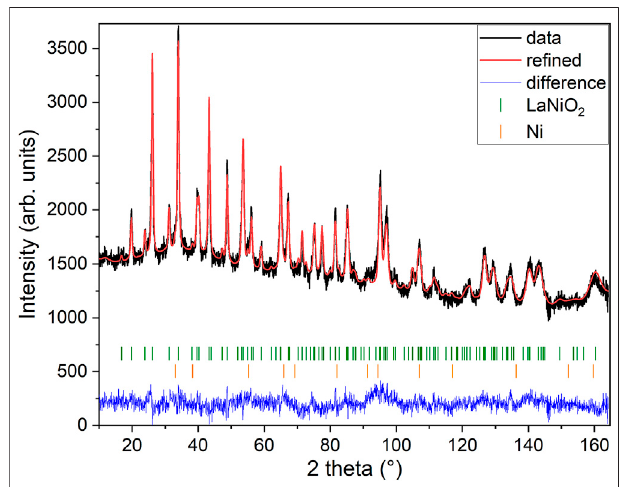
FIGURE 2 | Oxygen and hydrogen content of reduced LaNiO 3 after different reduction times. Red symbols correspond to the oxygen content x in LaNiO 3 − x , extracted from Rietveld re fi nements of the PXRD data shown in Figure1 .Thebluedatapointisextracted fromRietveld re fi nementofour neutron diffraction data shown in Figure 3 . The solid red line is a guide to the eye. The black symbols in the inset correspond to the hydrogen content y in LaNiO 3 − x H y , obtained from gas extraction. The solid black line is a guide to the eye.